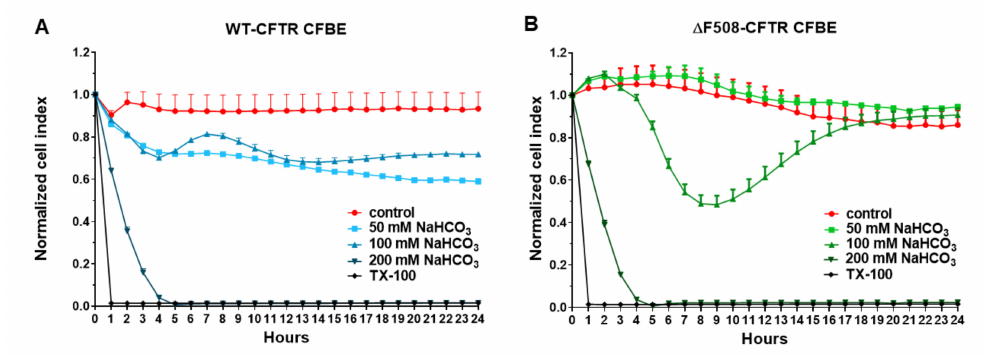
Figure 8. Impedance kinetics measurements of the WT-CFTR CFBE ( A ) and ∆ F508-CFTR CFBE ( B ) cells after sodium bicarbonate treatment at di ff erent concentrations (50, 100, 200 mM). Culture medium